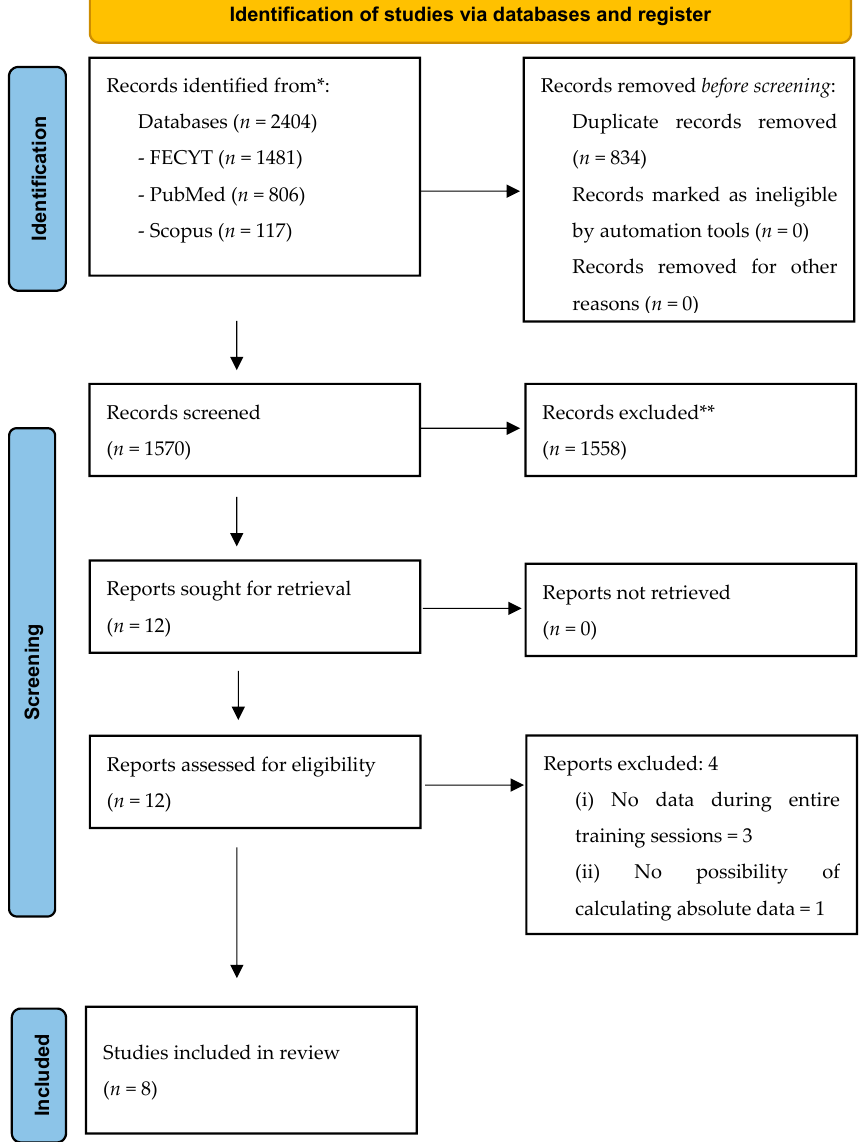
Figure 1. Preferred reporting item for systematic reviews (PRISMA) flow diagram.